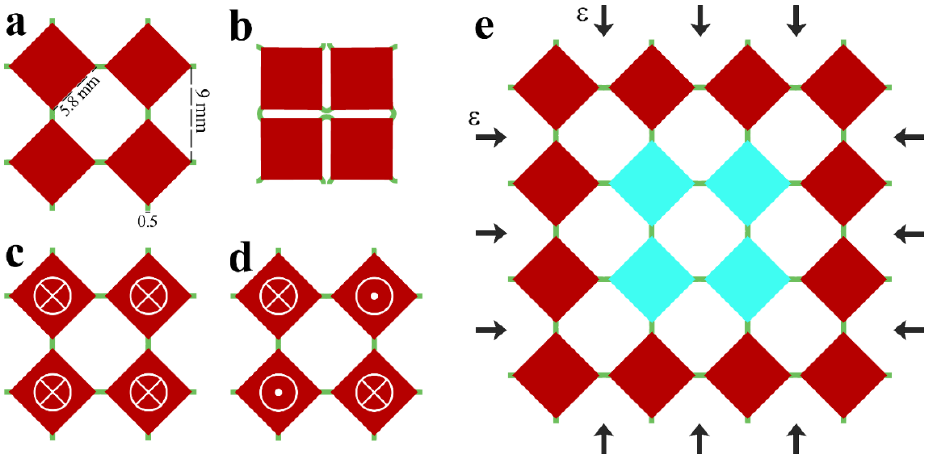
Figure 1. Design of studied mechanical metamaterial. (a) elementary cell in the open state; (b) elementary cell in the closed state; (c) modified (repulsive) elementary cell with co-directional magnets; (d) modified (attractive) elementary cell with counter-directional magnets; and (e) unit cell with embedded modified cell (shown by blue color) under biaxial compression.